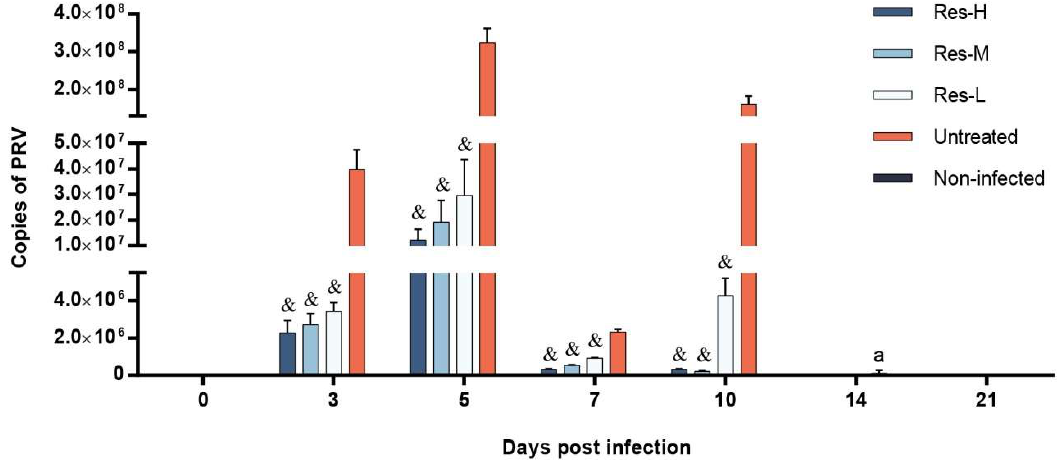
Figure 2. Copies of the PRV genome per nasal swab sample of piglets. Copies of PRV genome in nasal of the piglets were analyzed by FQ-PCR at 0, 3, 5, 7, 10, 14 and 21 dpi (at every selected time point, all of the living piglets were tested, n ≥ 3, in each group). There was no PRV genome detected in the non-infected group at any time point and no PRV genome detected at 0, 14 and 21 dpi among the groups. a There was one piglet detected with PRV in the untreated group at 14 dpi. Correlation analyses were evaluated by Pearson r2, & p < 0.001 vs. untreated group.